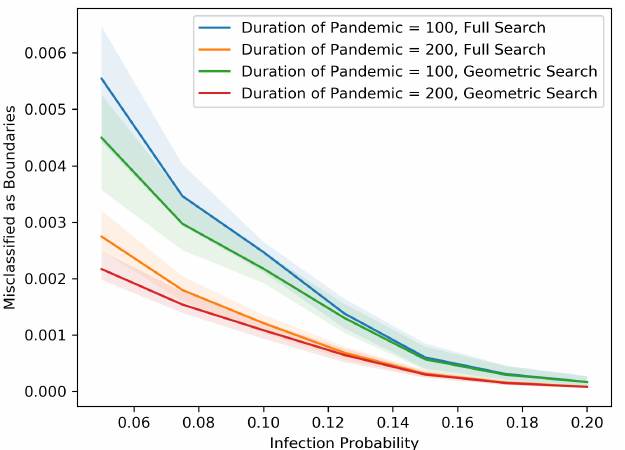
Figure 10. Misclassified As Boundaries. Population = 1,000,000 Non-cooperative Rate = 0. N: number of people inside and containing the external